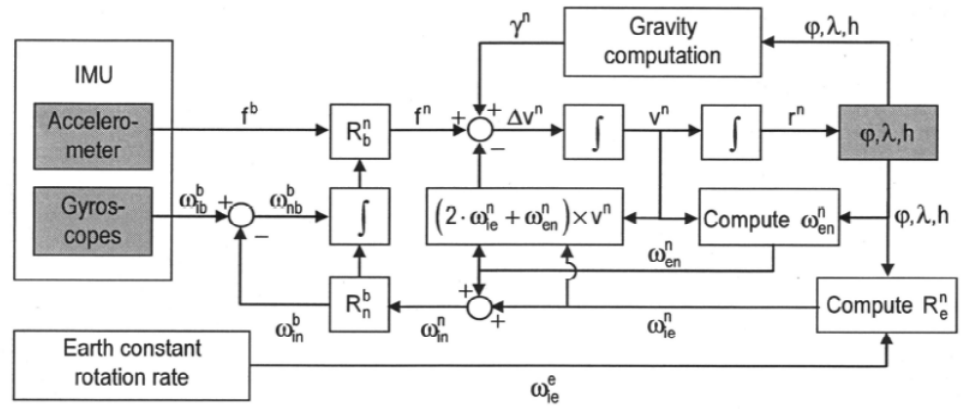
Figure 3. Scheme of the INS Mechanization equations